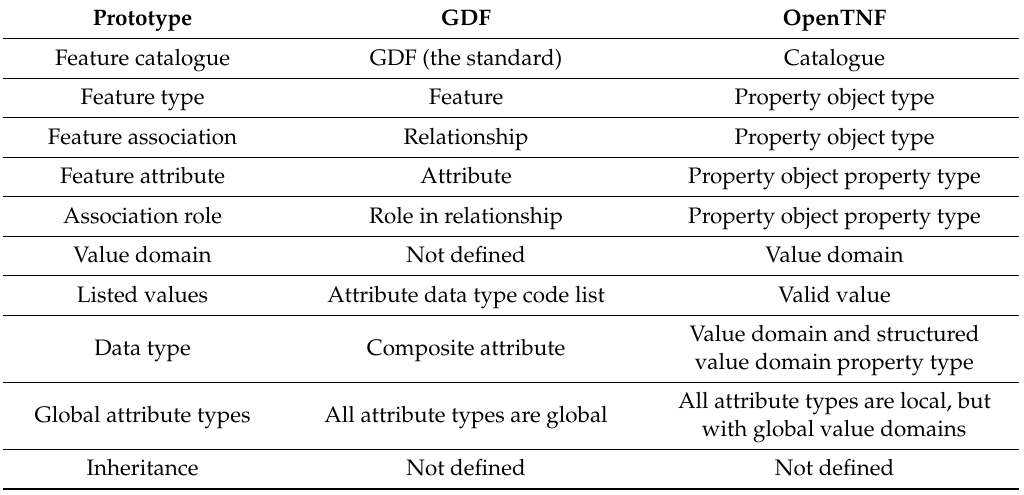
Table 5. Comparison of concepts from feature catalogue exchange models.